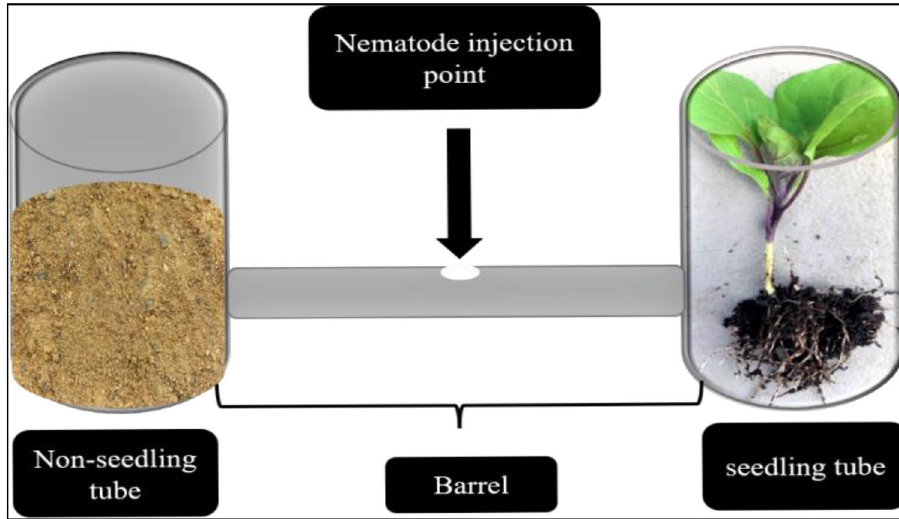
Figure 1. Schematic diagram showing the host finding pipette-tube assay unit (chemotaxis